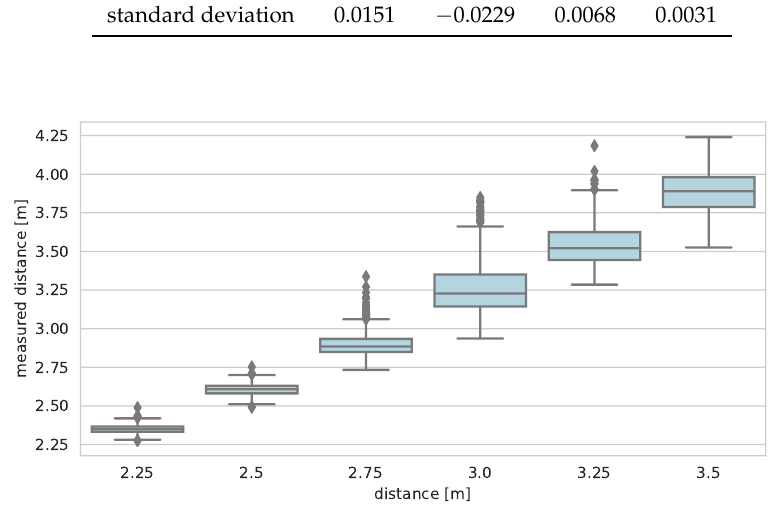
Figure 9. Boxplot of ranging results for the person dressed in a black shirt and located at larger